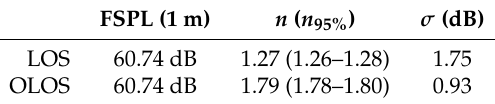
Table 3. CI path loss model